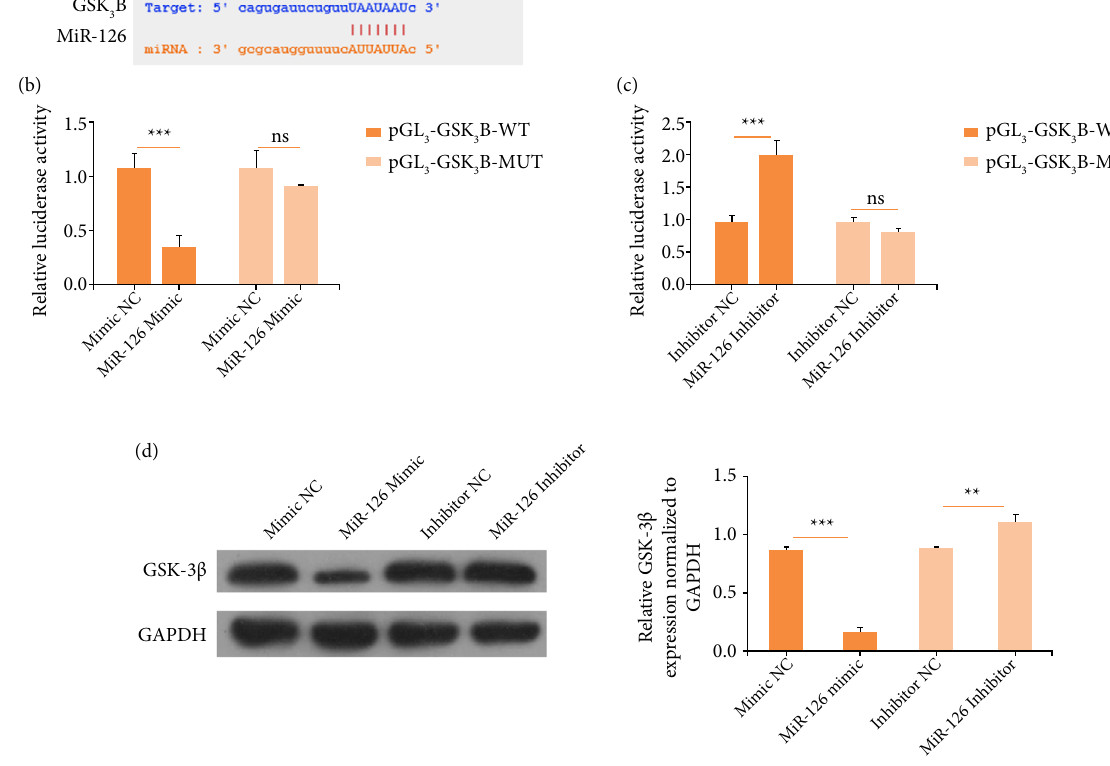
Figure 3 - MiR-126 can target GSK3B. (a) The complementary sequence between miR-126 and GSK3B. (b) Relative luciferase activity. (c) Relative luciferase activity. (d) Western blots for GSK-3 β expression. Naringin attenuates oxygen-glucose deprivation/recovery-induced apoptosis of cardiomyocytes